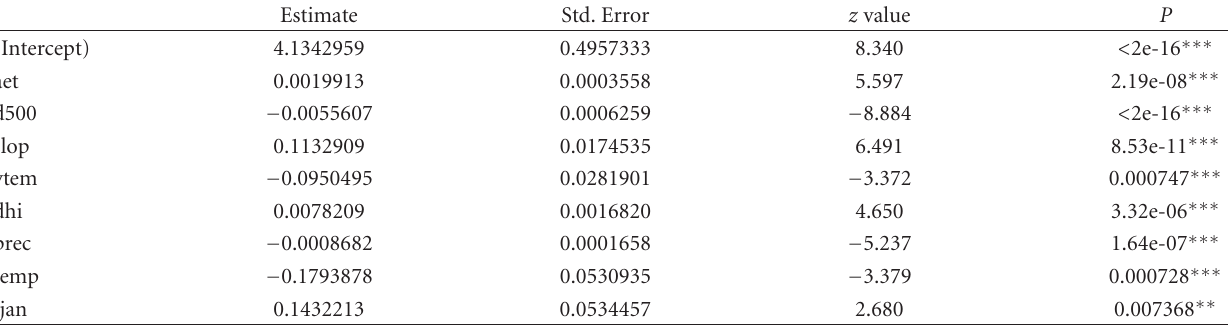
Table 6: B. bufo or B. calamita .